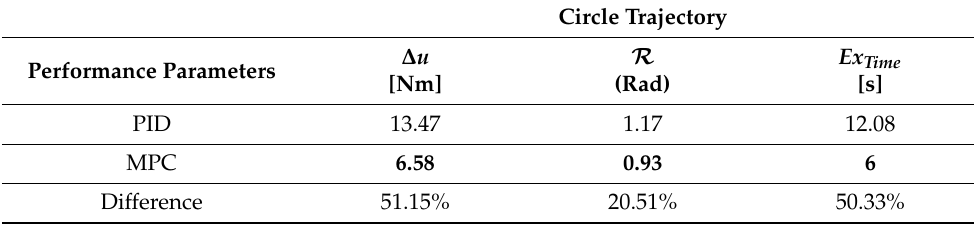
Table 8. Simulation results related to the performance parameters for circle motion reference